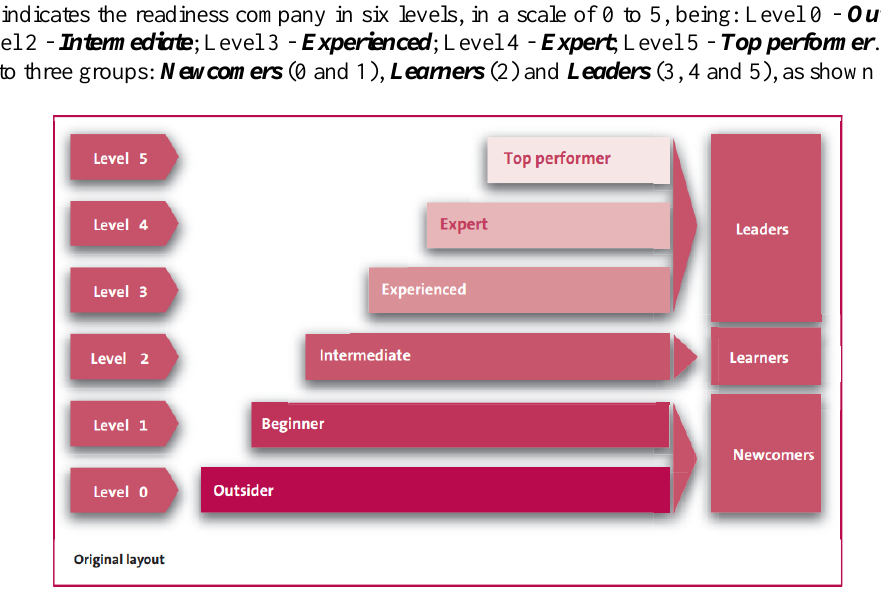
Figure 2. The six dimensions of the " Industrie 4.0 Readiness " model